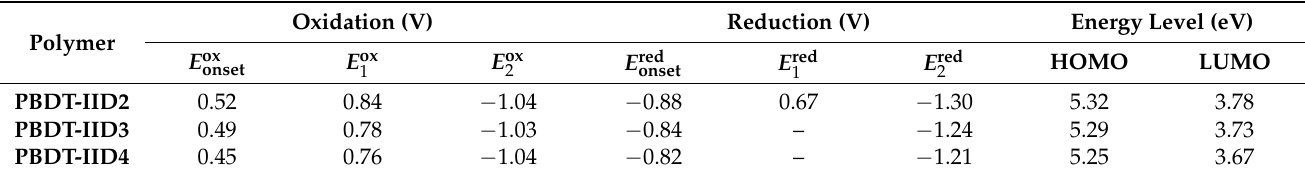
Table 3. The electrochemical properties of the